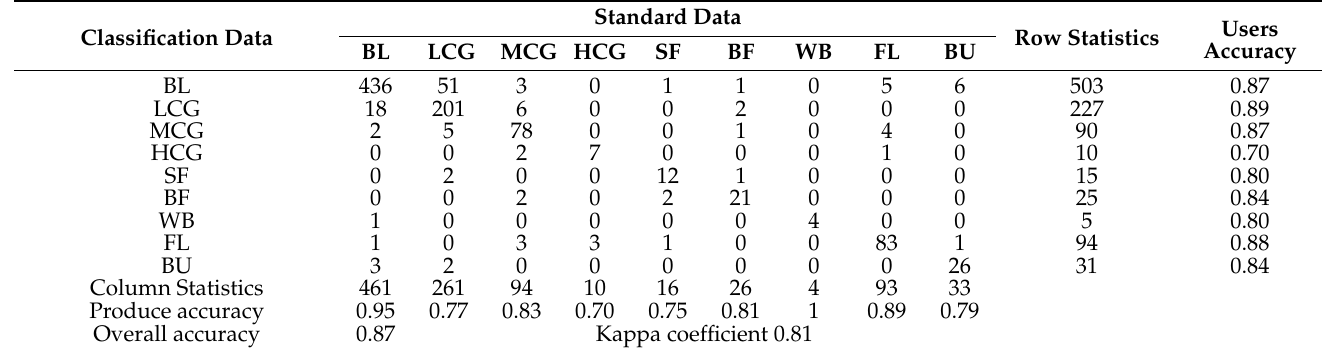
Table A2. Confusion matrix of land use mapping in Dunhuang oasis in 2010.